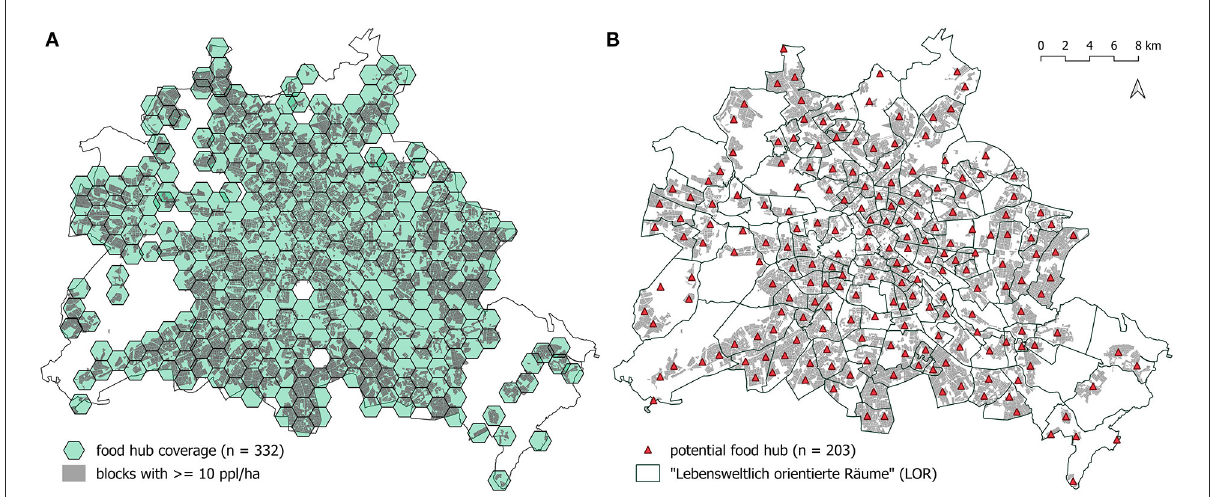
FIGURE2 The allocation of FHs in Berlin based on (A) the 15-min city concept and (B) the LOR.